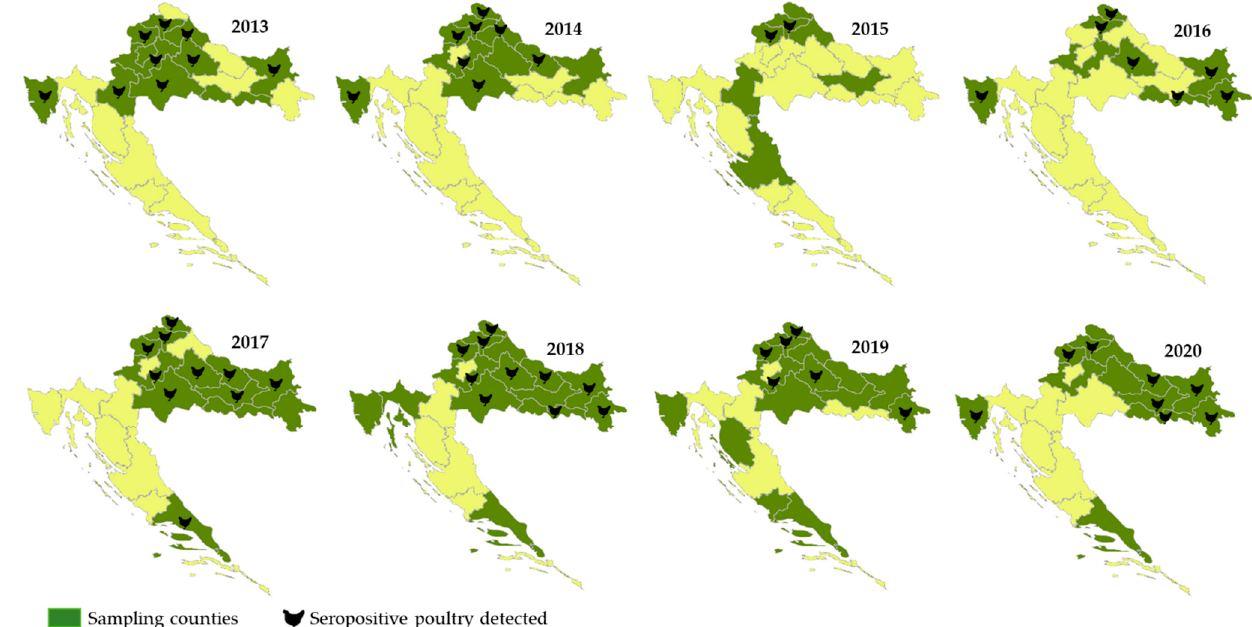
Figure 5. Geographic distribution of WNV seropositive poultry, 2013–2020.